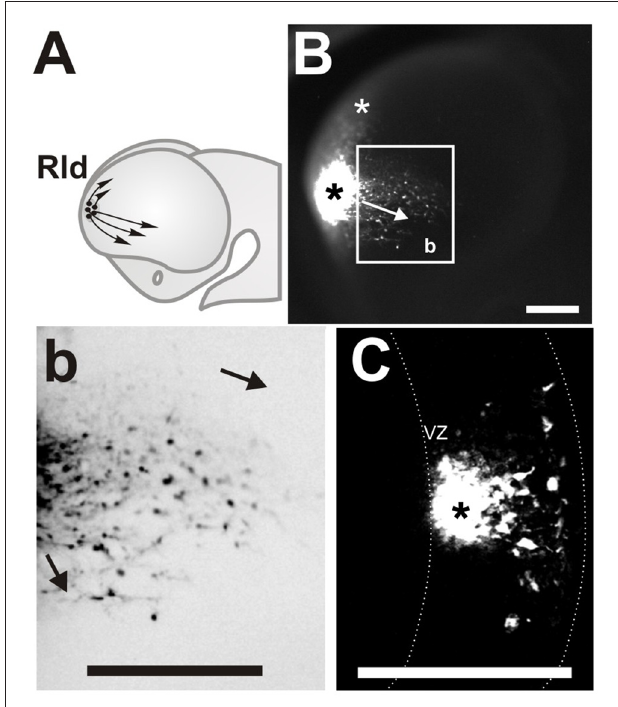
FIGURE 1 | Rostro Lateral Domain (Rld): a rostral site of cell generation with different migration routes. (A) Scheme of a developing forebrain showing the cells derived from the (Rld, black dots) and the dorsal and ventral directions of migration (arrows). (B) Lateral view of a telencephalic vesicle (E11.0 + 24 h in culture) showing a site of carboxy-fluorescein diacetate (CFDA) labeling at the Rld (black asterisk), labeled cells migrating in caudal and ventral directions (arrow in inset) and cells displaced dorsally (white asterisk). (b) Inverted color magnification of inset in (B) showing cells migrating in caudal and ventral directions. (C) Representative telencephalic coronal section showing the labeled site in the VZ (asterisk) and cells migrating radially towards the pial surface. Dotted line in (C) limits the borders of the neocortex in coronal sections. VZ: ventricular zone. Scale bar: 200 µ m.